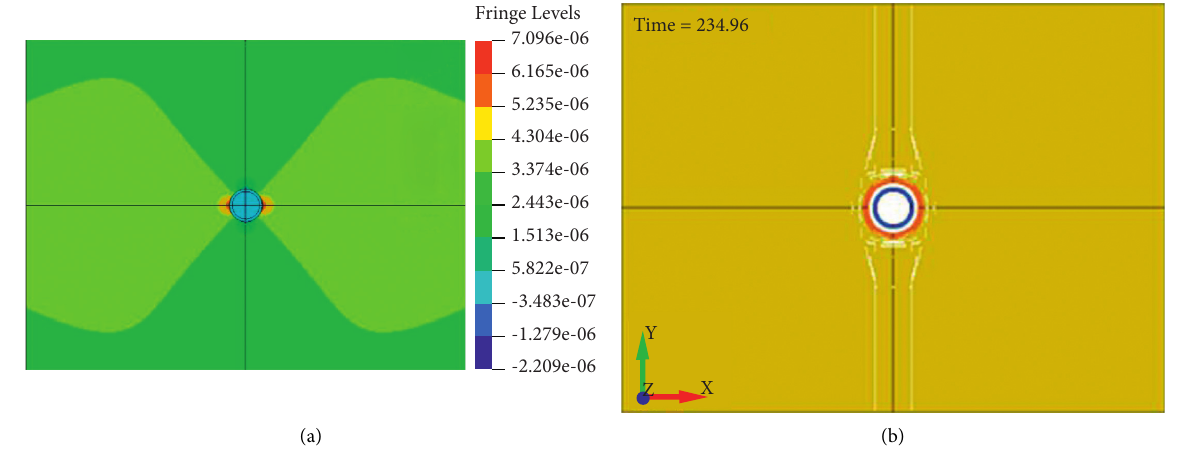
Figure 12: The distribution of stress and crack propagation around a blast hole under unidirectional in situ stress (Case III: P � 1.0 MPa). (a) Distribution of tensile and compressive stress. (b) Crack propagation along the loading direction.